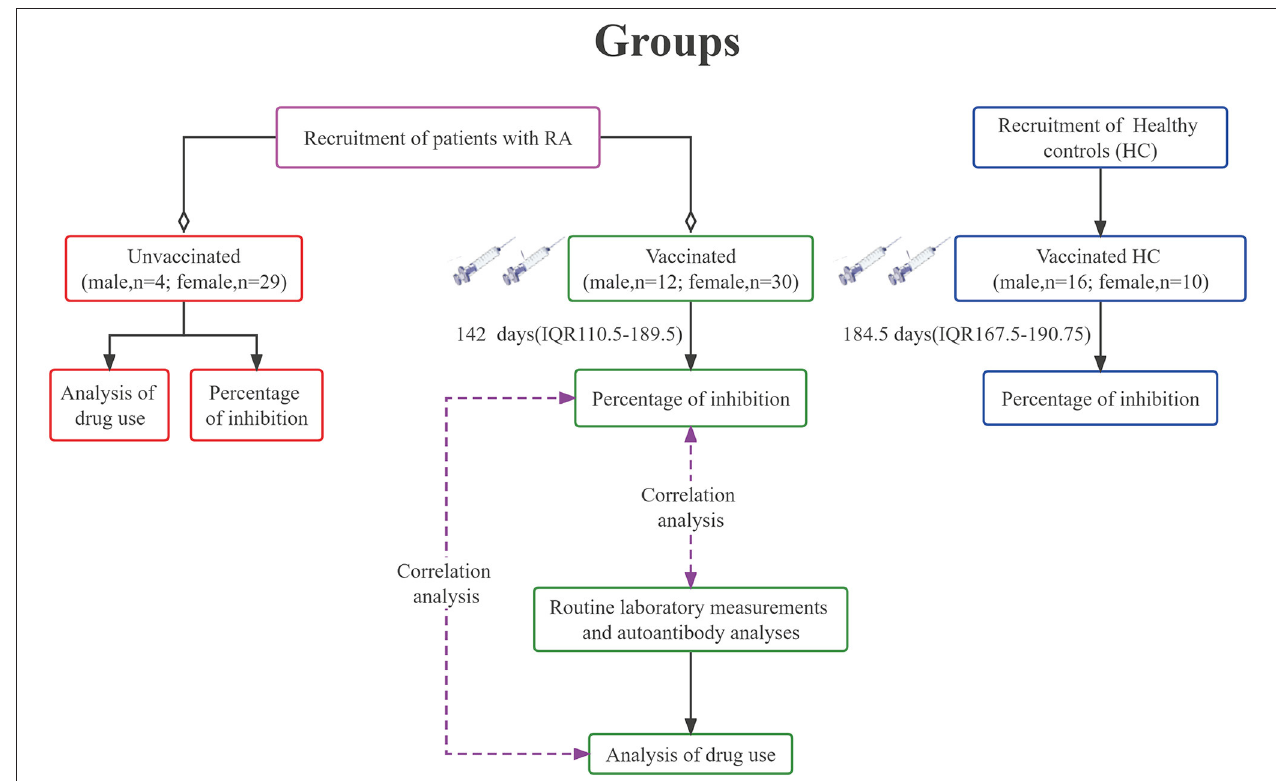
FIGURE 1 | A standard flow diagram for this